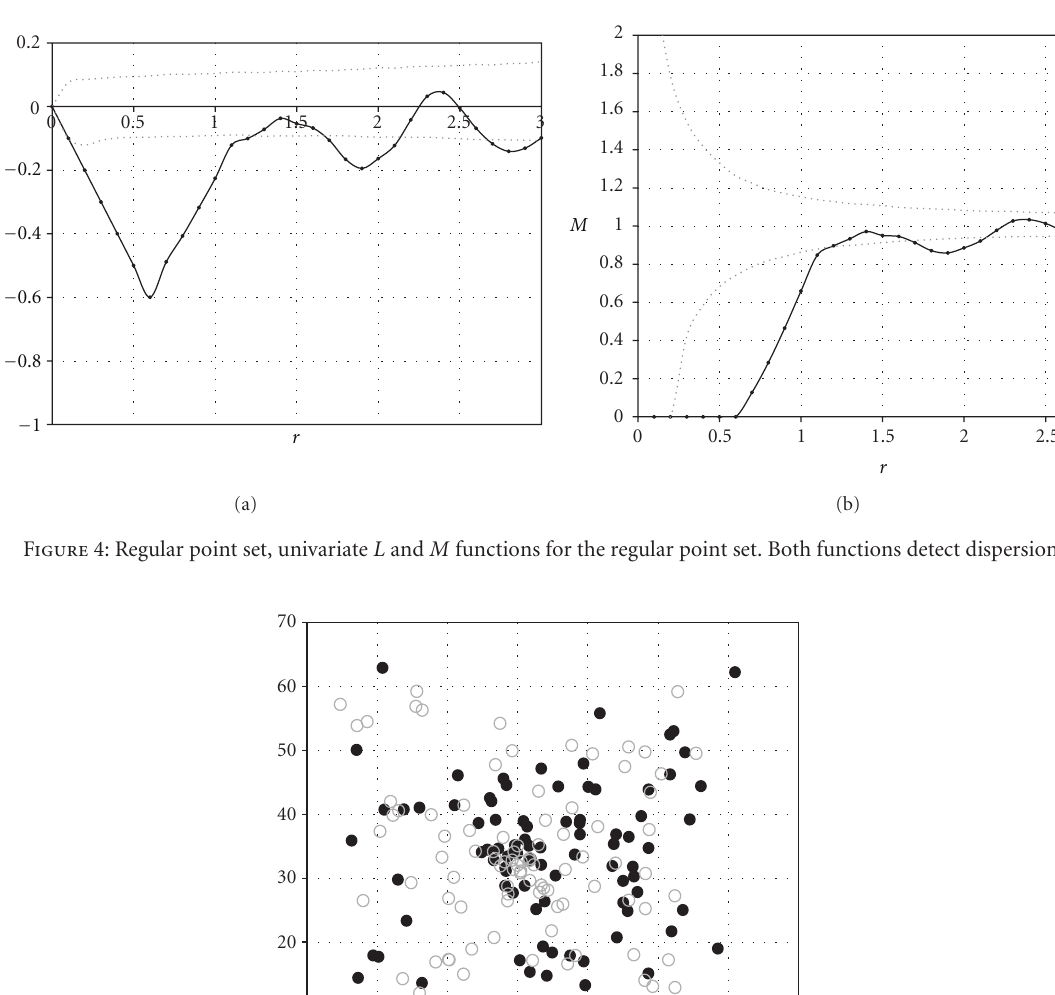
for this point pattern. The next year, Diggle and